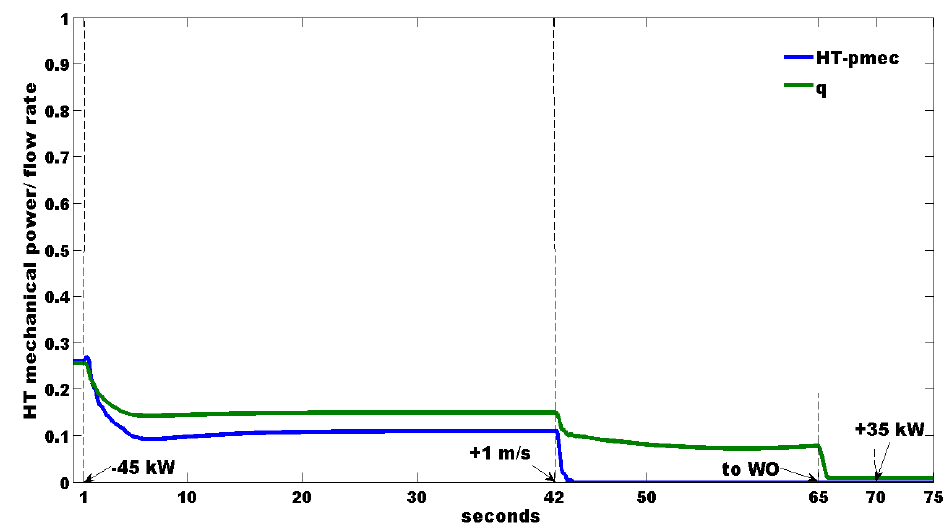
Figure 9. Hydro Turbine (HT)